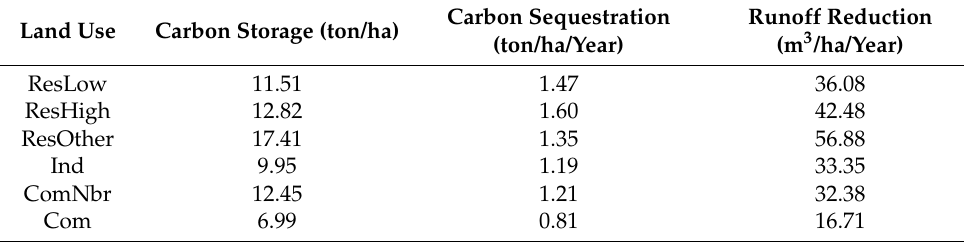
Table 5. Ecosystem services efficiency in Kyoto City.